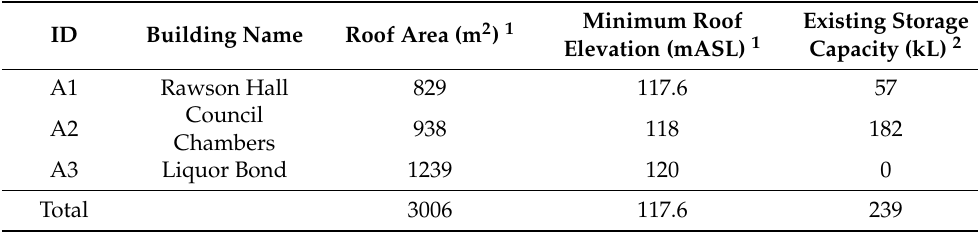
Table 2. Building specifications of potential cluster-scale RHRWSs near Bicentennial Oval. Location of buildings shown on Figure